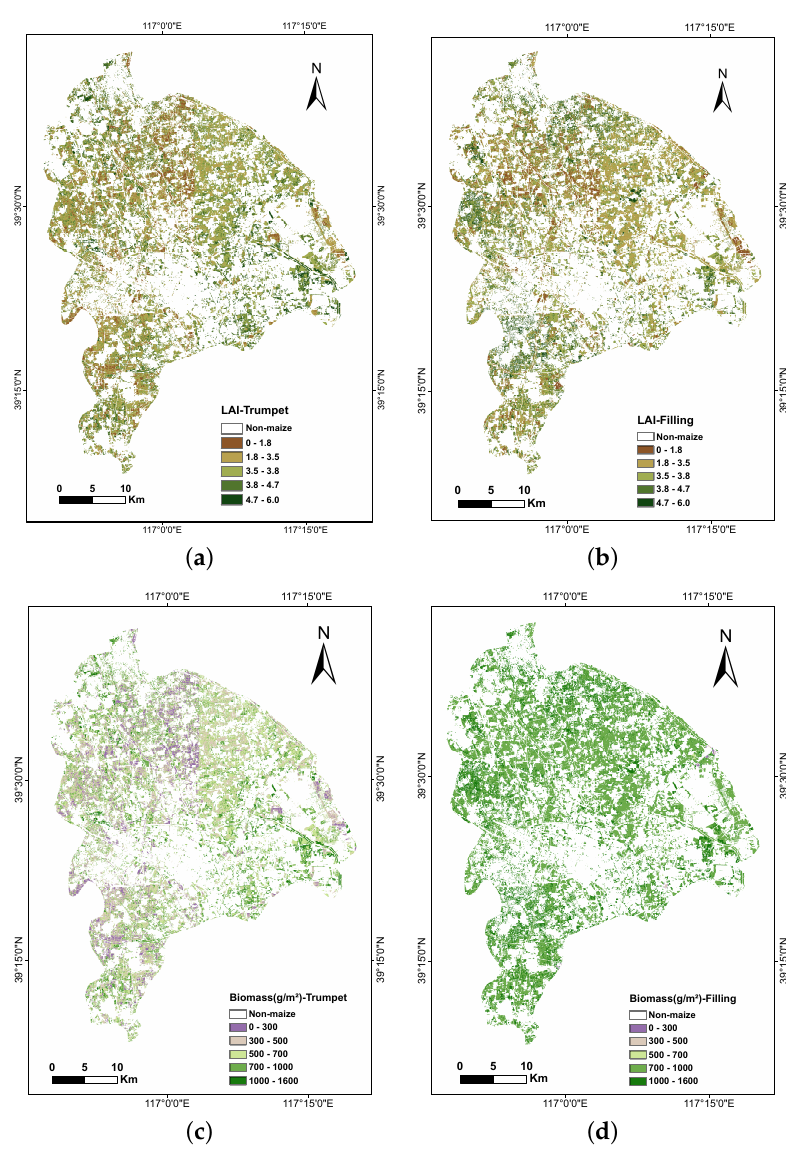
Figure 6. Results of maize LAI and biomass estimation based on the GSDNN with mixup + : ( a ) LAI— Trumpet; ( b ) LAI—Filling; ( c ) Biomass—Trumpet; ( d )